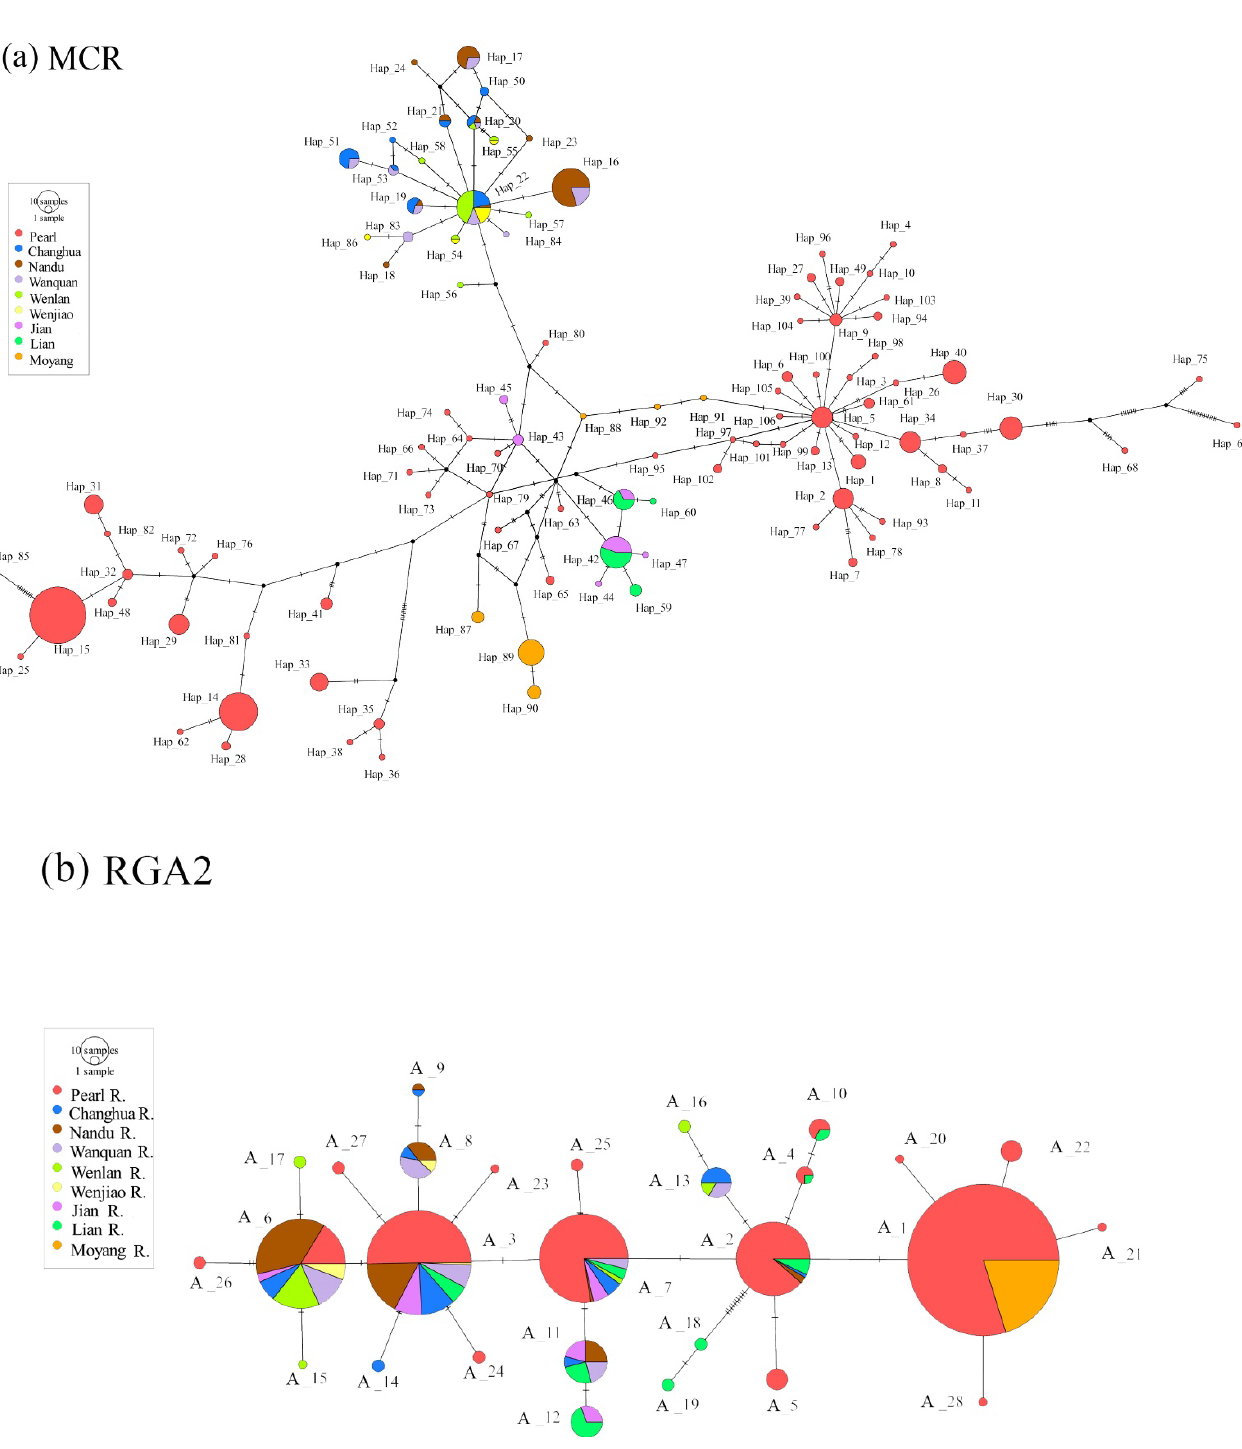
Figure 2. Haplotype ( a ) and allele ( b ) networks for the nine rivers included in this study based on concatenated mitochondrial locus (MCR) and RAG2 data. Circles are proportional to sample size (scale differs between networks) and colored based on geographical origin.